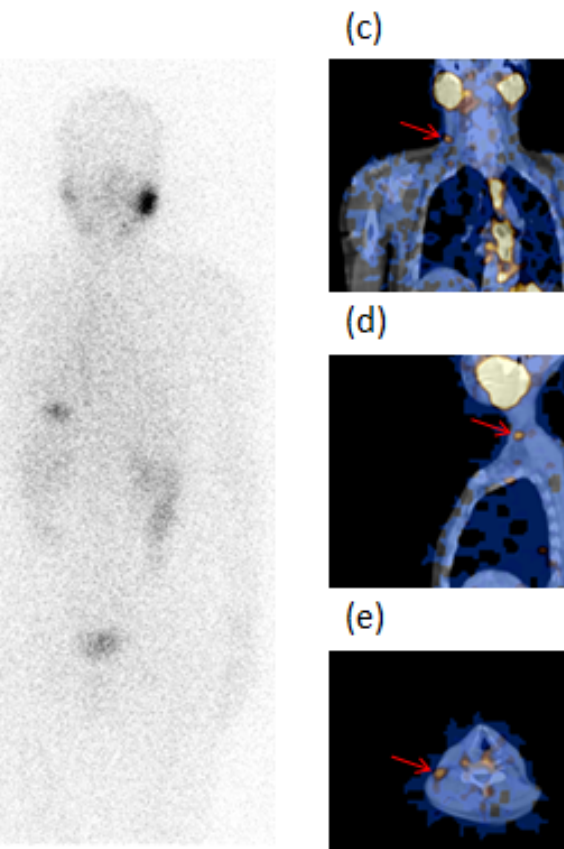
Figure 1. A 48-year-old male patient (Case 5, Table 2) submitted to total thyroidectomy and radioiodine ablation for papillary carcinoma (PC) classic variant, tumor diameter of 4 mm with associated Graves’ disease (GD). The figure refers to an image acquired after 24 months of follow-up. 131 I-WBS, after a diagnostic dose of 185 MBq, in both anterior ( a ) and posterior ( b ) views did not evidence pathologic radioiodine-avid foci. SPECT/CT in coronal ( c ), sagittal ( d ), and transaxial ( e ) slides showed a radioiodine-avid focus in right laterocervical region of the neck (red arrow) which was classified as metastatic lymph node, confirmed at surgery. Thyroglobulin: undetectable. AbTg: absent. Of the remaining 4/14 Group 1 cases (Cases 11–14), 2/4 of patients with unifocal carcinoma and neck LN metastases at surgery developed a new neck LN metastasis (1